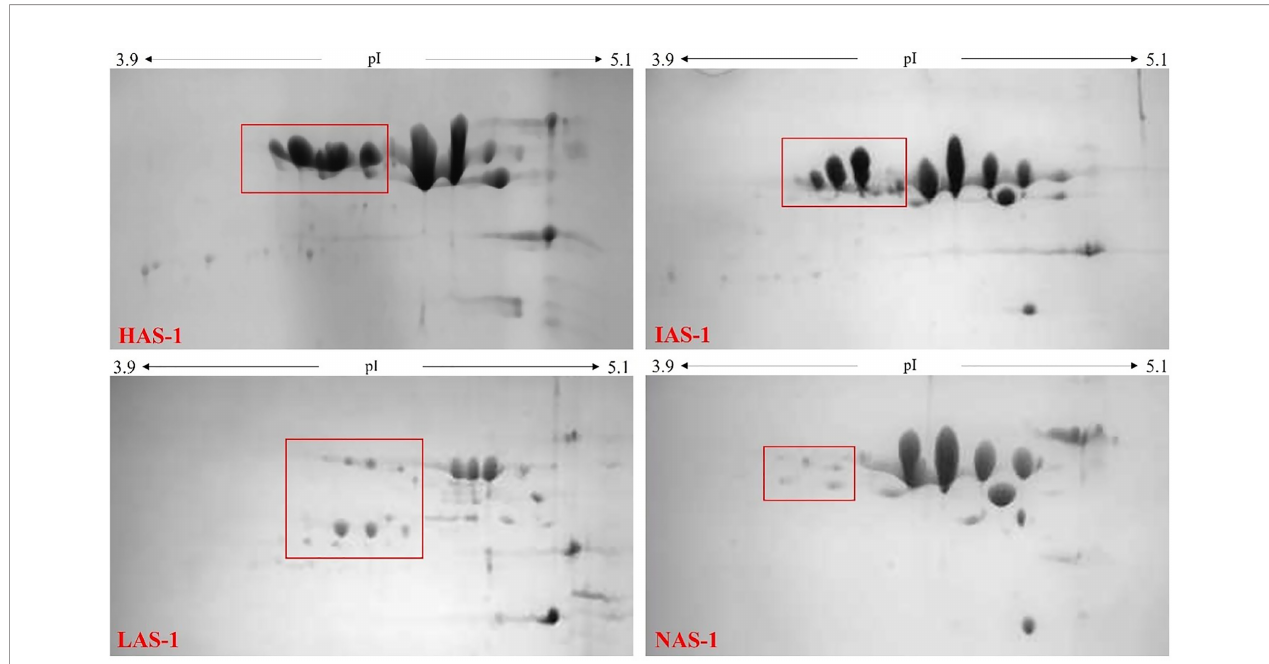
FIGURE 1 | 2D-electrophoresis gels of milk with different a s1-casein expression levels: High a s1-casein expression level (HAS-1); Intermediate a s1-casein expression level (IAS-1); Low a s1-casein expression level (LAS-1); Null a s1-casein expression level